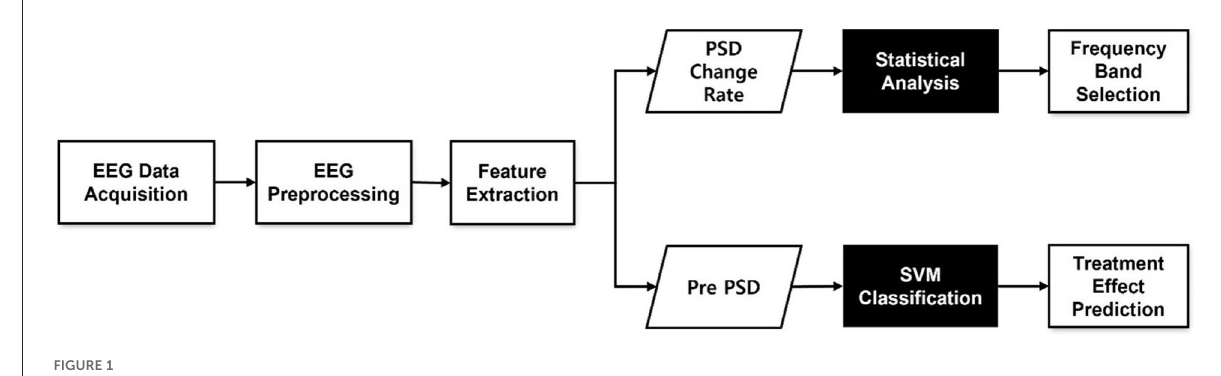
FIGURE1 The flowchart of overall analysis